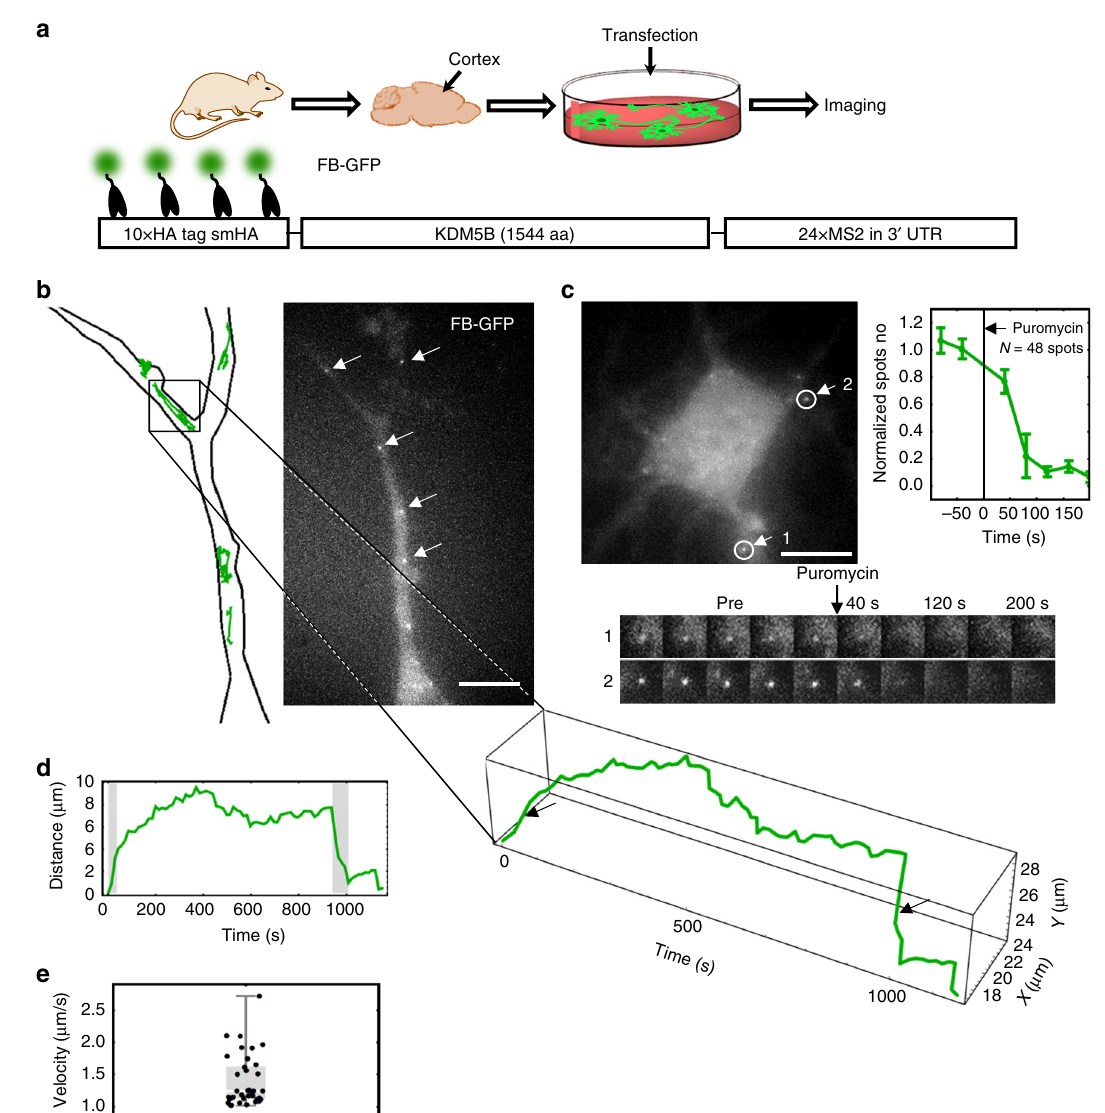
Fig. 8 Monitoring local translation in living neurons. a A diagram depicting the preparation of rat primary cortical neurons for imaging. b The dendrite of a sample living neuron expressing frankenbody (FB-GFP) and the smHA-KDM5B-MS2 translation reporter ( n = 15 cells in two independent experiments). White arrows indicate translation sites that were tracked, as depicted in the cartoon on the left. The spatiotemporal evolution of one mRNA track with directed motion is shown through time. c Puromycin treatment of a representative cell. Two circled translation sites were tracked as they disappeared following the addition of puromycin. Upper-right: The mean number of nascent chain spots normalized to pre-puromycin levels decreases after puromycin treatment ( N = 48 spots from three cells in three independent experiments). Error bars, cell-to-cell SEM. d The travel distance through time for the translation spot highlighted in b . Gray highlights in d and black arrows in b indicate directed motion events. e Plot of velocities faster than 1 µ m/s (37 velocities from eight cells in two independent experiments). Mean: 1.40 ± 0.07 mm/s (spot-to-spot SEM). See also Supplementary Fig. 6. Scale bars, 10 µ m. Source data are provided as a Source Data fi le. For the box and whisker plots, median is shown by a white line, the box indicates 25 – 75% range, and whiskers indicate 5 – 95%